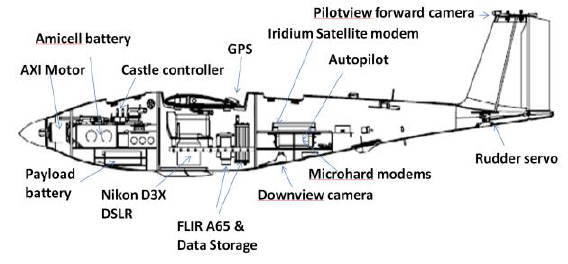
Figure 2: Internal arrangement of equipment in forest fire research configuration